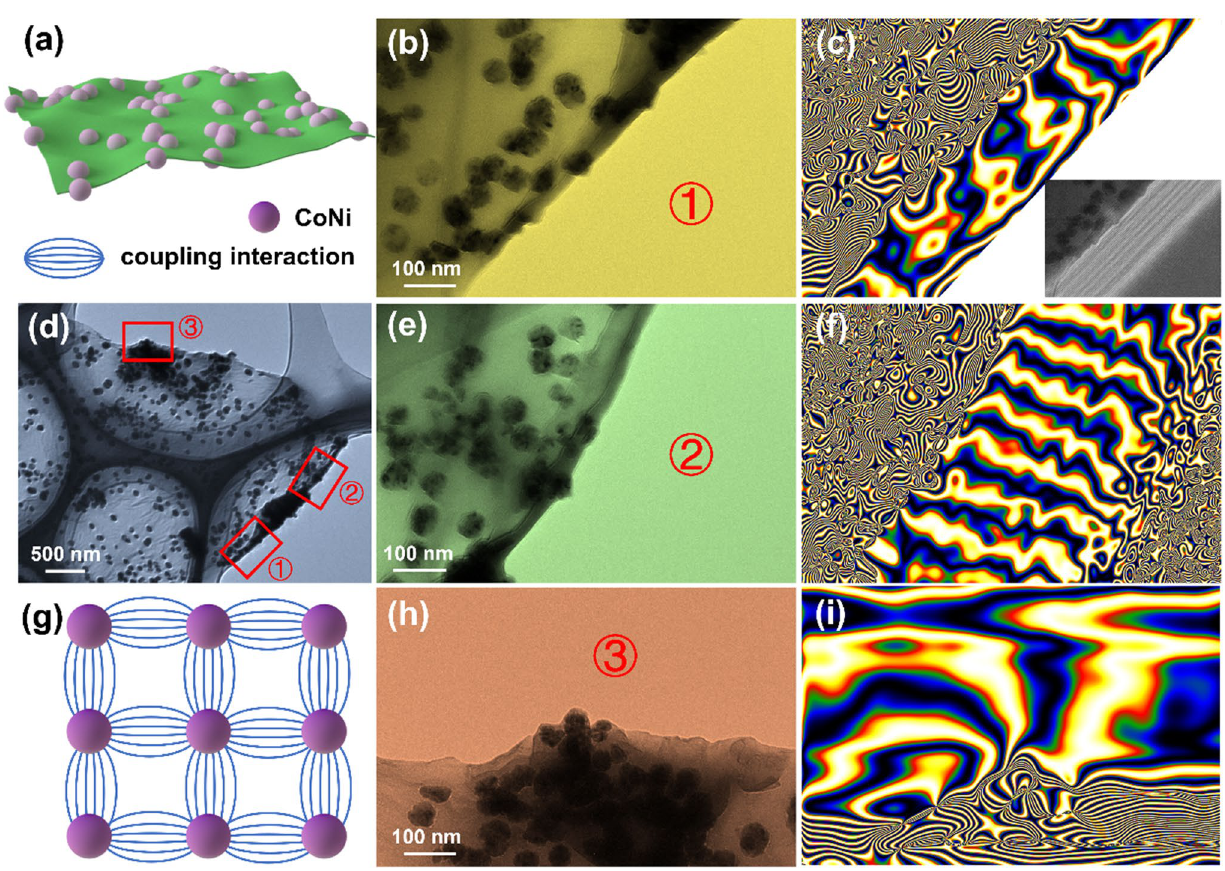
Fig. 9 a , g Schematic illustration, b , d , e , h TEM images and c , f , i magnetic flux lines of rGO/CoNi